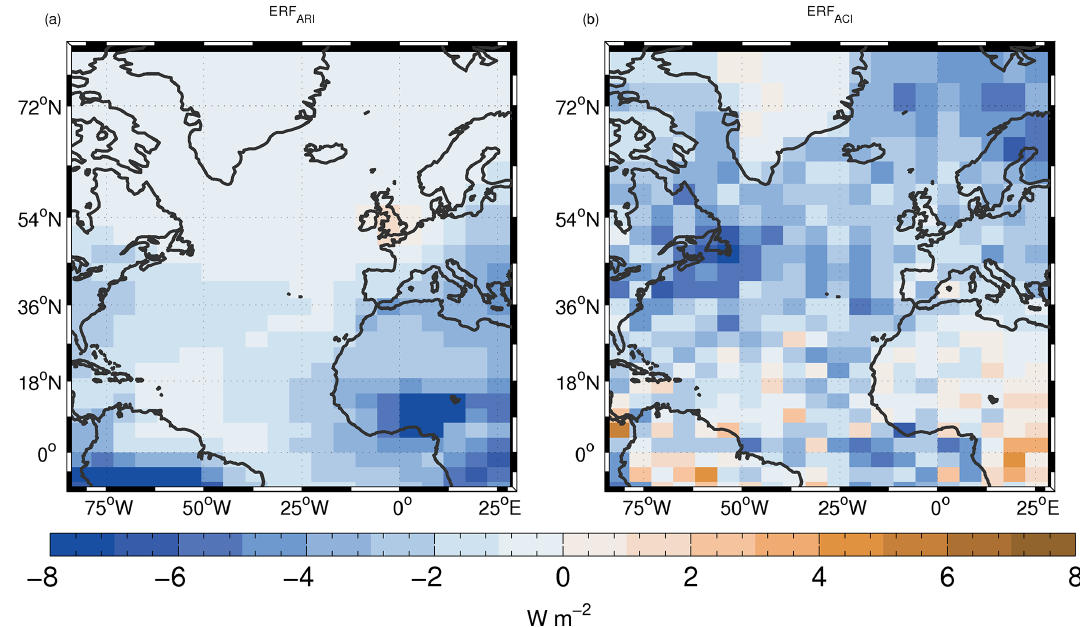
Figure H1. As for Fig. 12 except for the 2010–2011